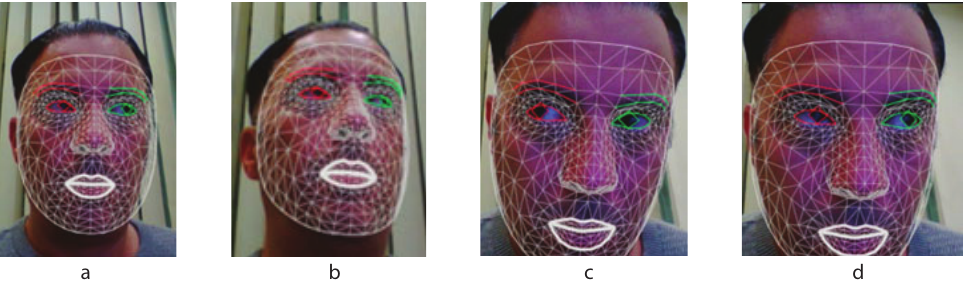
Figure 3. Examples of MediaPipe Face Mesh detection results realized in our laboratory: ( a ) frontal face, ( b ) head rotation, ( c ) gaze in the left, ( d ) gaze in the right.